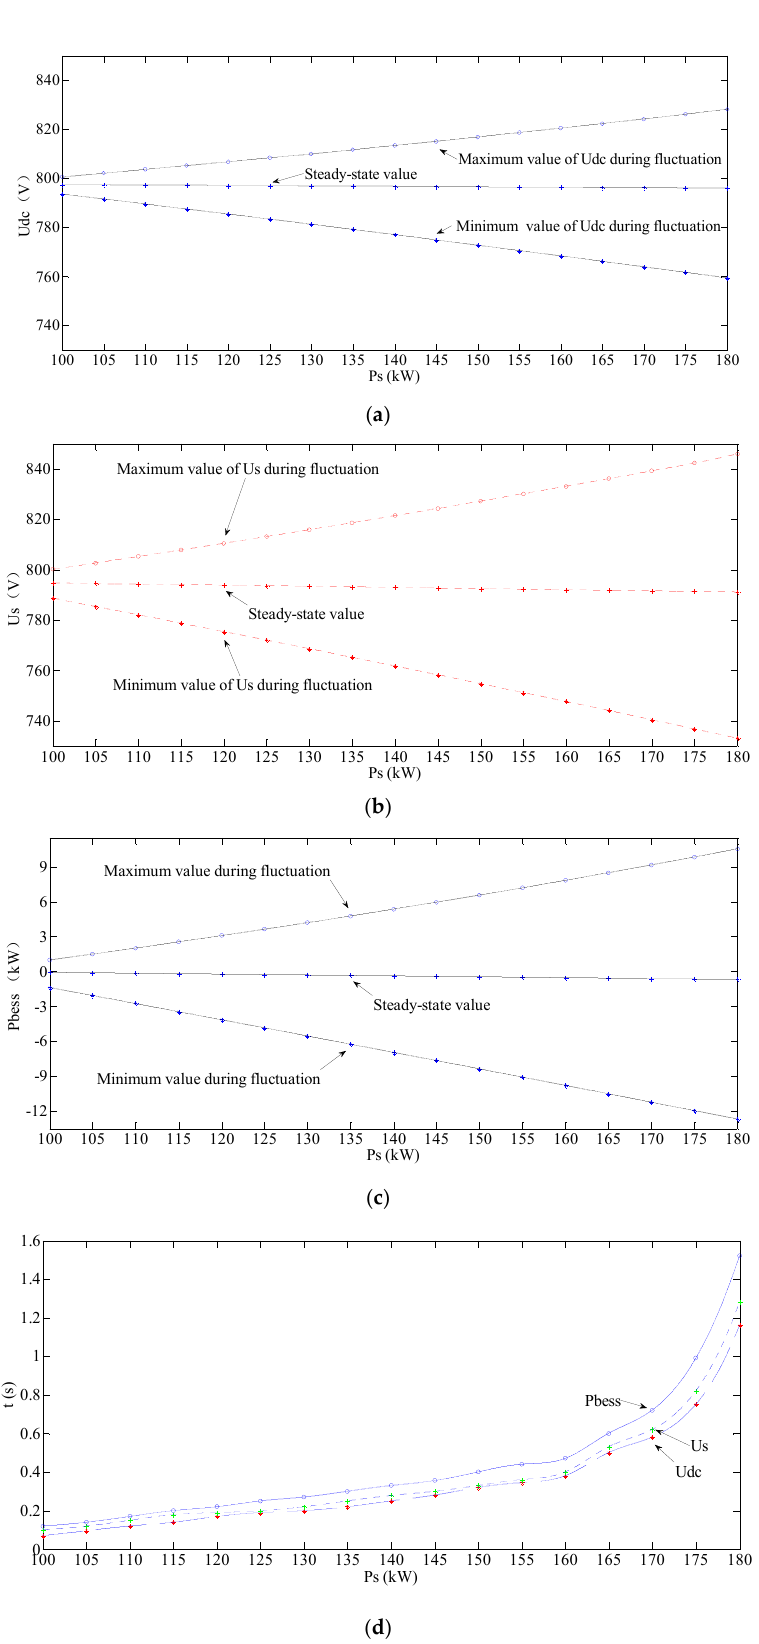
Figure 12. The performance comparison with the implementation of the addition control: ( a ) DC bus voltage; ( b ) DC-side voltage of VSC2; ( c ) The additional power of the ESS; ( d ) The steady-state recovering time.